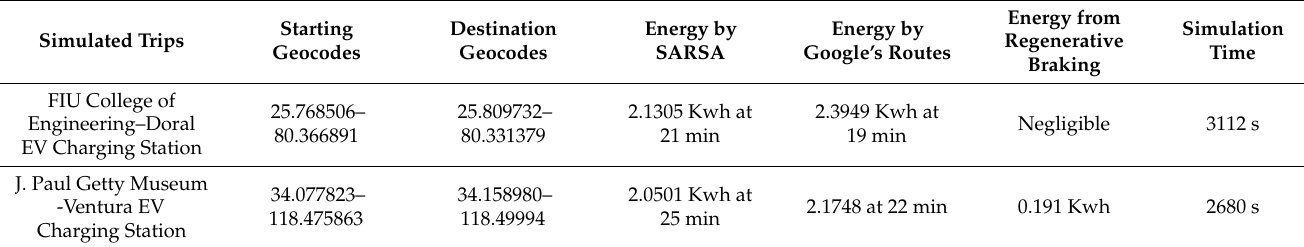
Table 3. Experimental information and results.